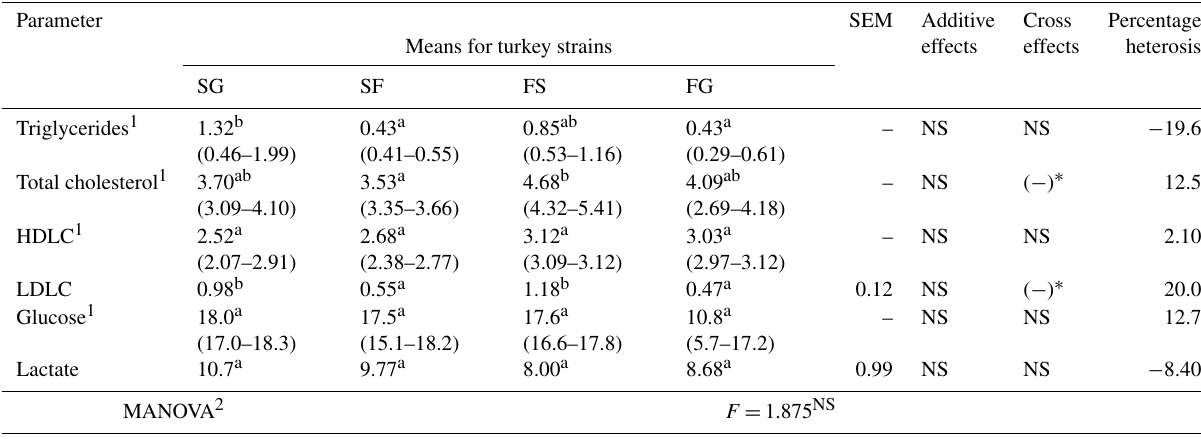
Table 2. Means, SEM or medians, lower and upper quartiles (in brackets), and orthogonal contrasts on lipoprotein lipid composition, glucose, and lactate values in serum (mmolL − 1 ) of female turkeys from different genetic groups.